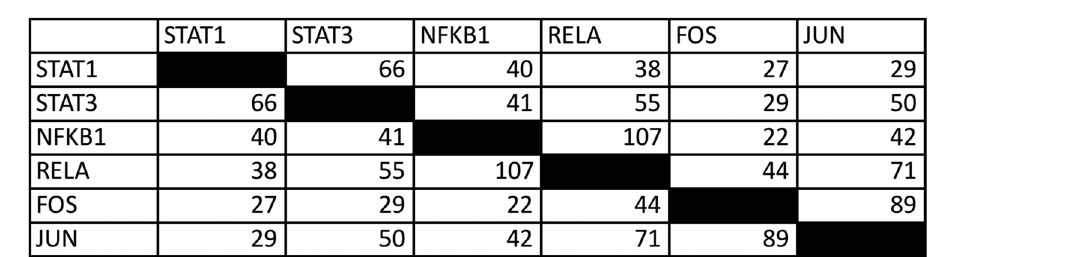
Table 3: Pairwise matrix of critical signaling hubs in innate and adaptive